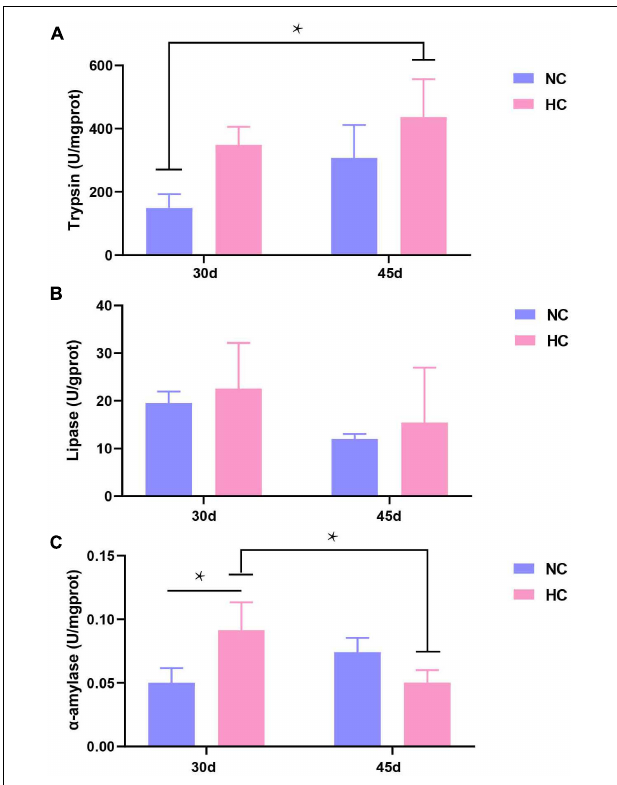
FIGURE 7 | Intestinal digestive enzyme activities of largemouth bass (A–C) Trypsin, lipase, and α -amylase activity after 30 and 45 days, respectively (* P < 0.05. NC: 0% α -starch diet, FC: 22% α -starch